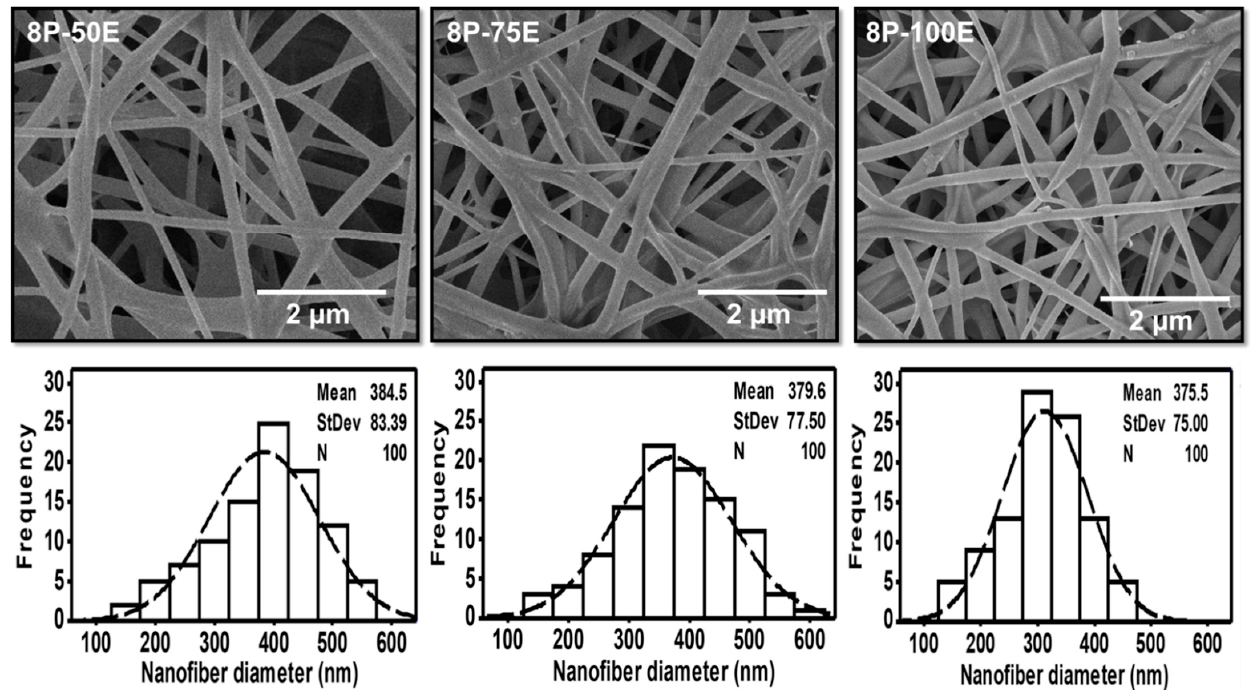
Figure 3. SEM images and histogram of diameter distribution of the developed electrospun nanofibers with different AI /water ratios 50:50, 75:20, and 100:0 while keeping the PVA concentration at 8 wt/wt%.